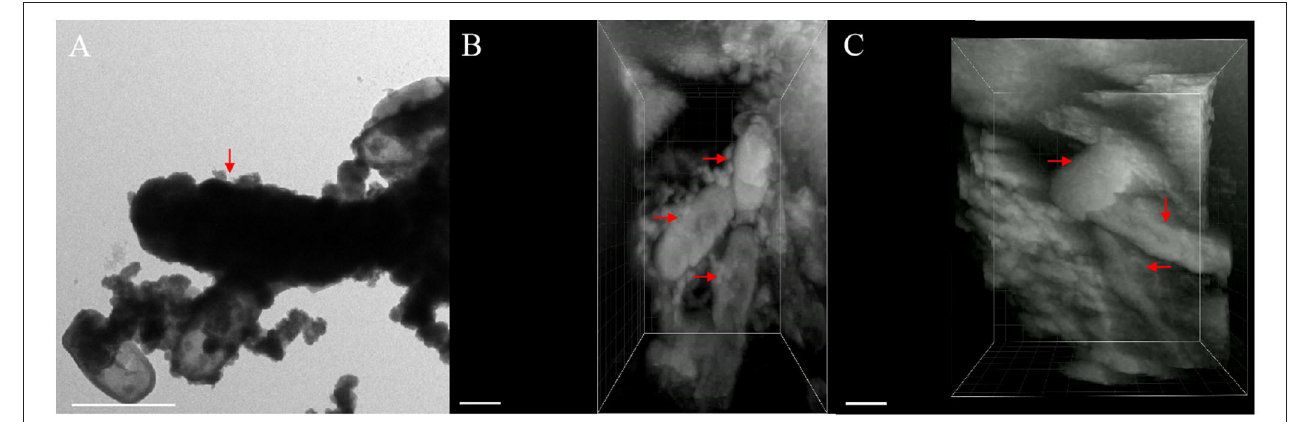
FIGURE 6 | TEM images of cell mineralization oxidizing by Acidovorax sp. strain BoFeN1 (A,B) and Rhodobacter ferrooxidans strain SW2 (C,D) , scale bar = 1 µ m.